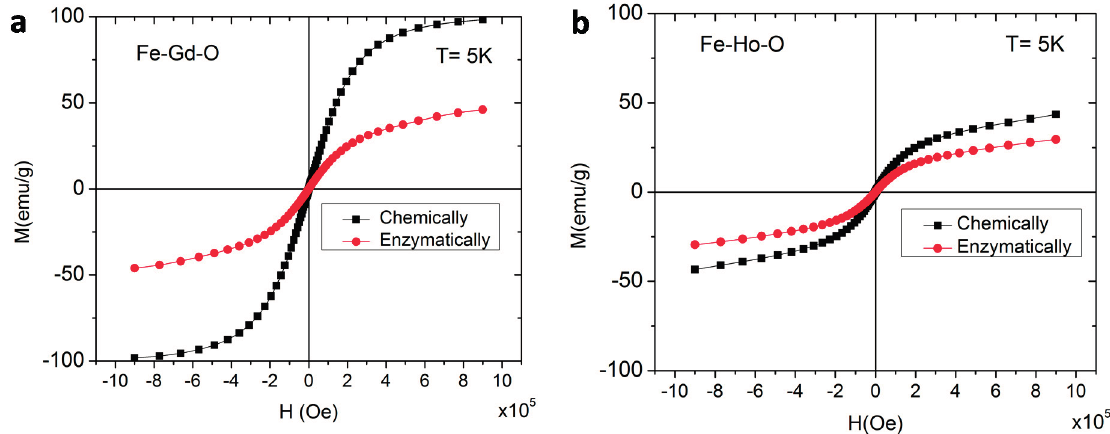
Figure 10. Magnetization curves recorded at 300 K for ( a ) the chemically-synthesized Fe 43±18 Gd 2±0 O 55±18 MNPs and the enzymatically-synthesized Fe 45±14 Gd 5±2 O 50±15 MNPs and ( b ) the chemically-synthesized Fe 3±1 Ho 11±2 O 85±3 MNPs and the enzymatically-synthesized Fe 42±4 Ho 6±4 O 52±5 MNPs.